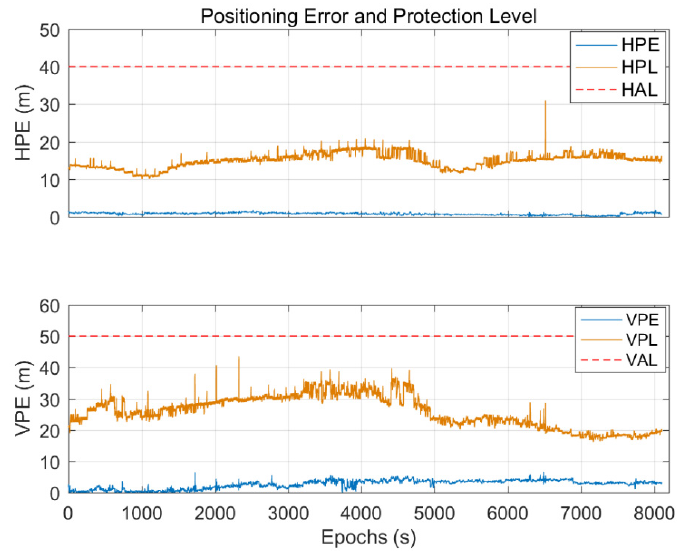
Figure 17. The PE, PL, and AL sequences of flight test-II. In both the horizontal direction (see the top panel) and the vertical direction (see the bottom panel), the PL can completely cover the PE and neither exceeds the PL, which means that no false alarms or missed alarms occurred during the test.